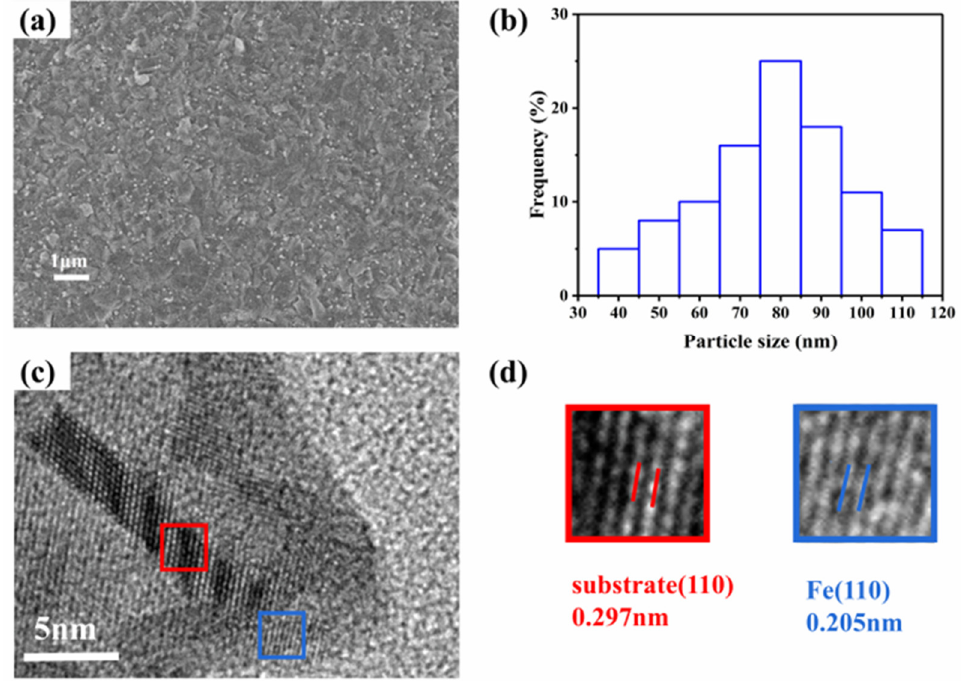
Figure 4. Morphological characterization of the sample. ( a ) SEM image, ( b ) plot of frequency vs. particle sizes, ( c ) TEM image, and ( d ) high−resolution TEM representing the lattice distance (lines of red and blue).